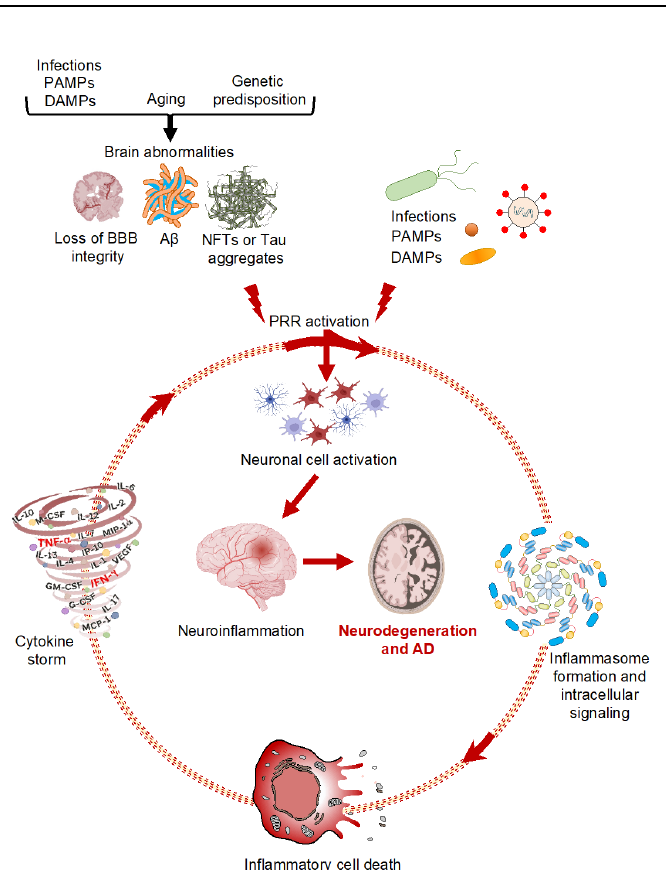
Figure 1. Innate immune signaling and neurodegeneration. Schematic representation of different Alzheimer’s disease triggers activating innate immune signaling, neuroinflammation, and inflam- matory cell death in neurodegenerative disorders. Created with Biorender (accessed on 12 May 2022). Inflammation must be tightly balanced in the brain. A proinflammatory environ- ment, such as that seen in AD brains, accounts for damaging pathology. The increased caspase-1 activation in AD leads to higher levels of IL- 1β release [88,210] ; this can be